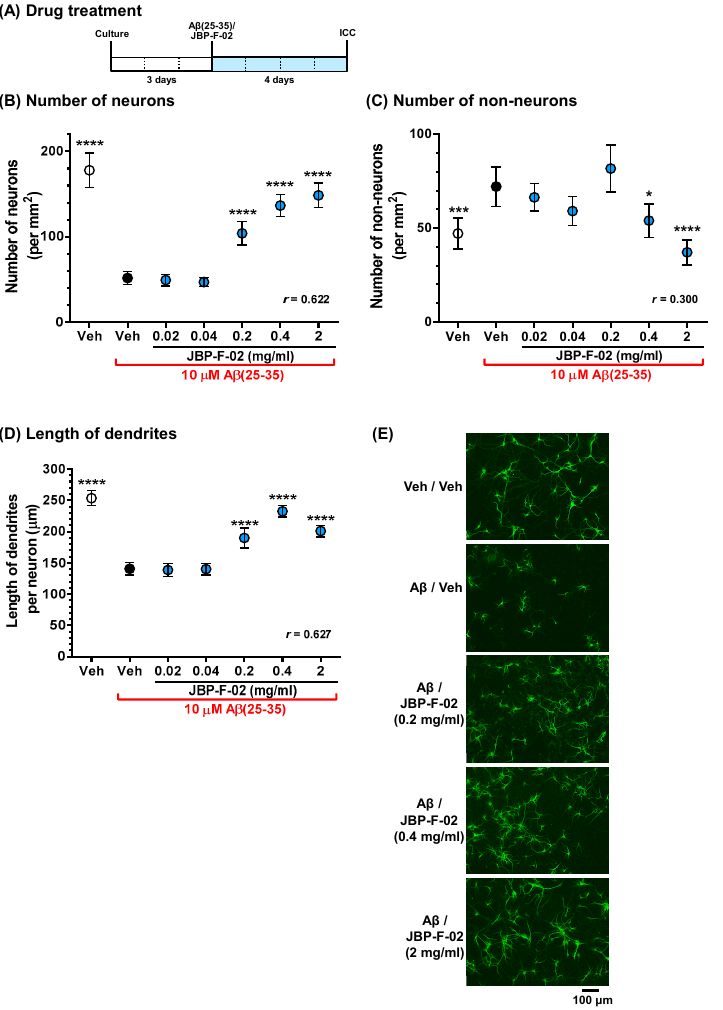
Figure 2. Effects of JBP-F-02 on A β -induced neuronal loss and dendrite atrophy . ( A ) Cortical neurons were cultured for 3 days and then treated with or without aggregated A β 25–35 (10 μ M). At the time of A β 25–35 addition, the cells were simultaneously treated with JBP-F-02 at 0.02, 0.04, 0.2, 0.4, and 2 mg/mL concentration or a vehicle solution (distilled water). Four days after the treatment, the cells were fixed and immunostained for MAP2. Counter staining was done by DAPI. ( B ) MAP2-positive and DAPI-positive cells were counted as neurons. ( C ) MAP2-negative and DAPI-positive cells were counted as non-neurons. ( D ) The length of MAP2-positive dendrites. ( E ) Representative photos of the im- munostained dendrites are shown; * p < 0.05, *** p < 0.001, **** p < 0.0001 vs. A β 25–35-treated and vehicle solution-treated cells (black circle), one-way analysis of variance with post hoc Bonferroni’s test, n = 98 photos. Scale bar indicates 100 µ m. Means ± 95% CI. A β , amyloid β ; DAPI, 4’,6-diamidino-2-phenylindole